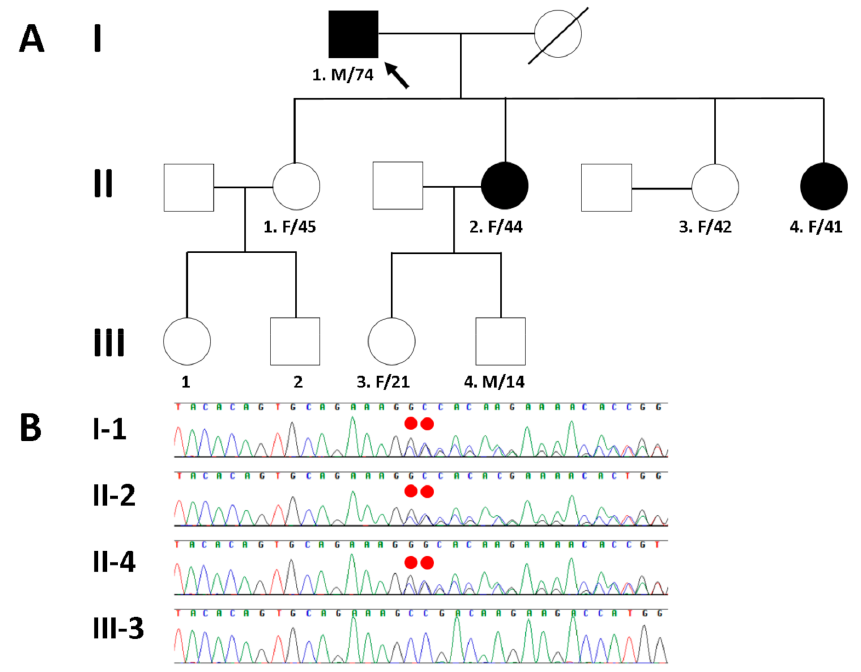
Figure 3. ( A ) Pedigree of the proband (arrow) and his family members with different cardiomy- opathies caused by a heterozygous MYBPC3 frameshift mutation. ( B ) Sanger sequencing confirmed a heterozygous frameshift mutation (NM_000256.3:c.3313_3314insGG; p.Ala1105Glyfs*85) of MYBPC3 , which was inherited in an autosomal dominant manner in the proband (I-1) and his affected daugh- ters (II-2 and II-4), but not in his unaffected granddaughter (III-3). The mutation is highlighted by the red